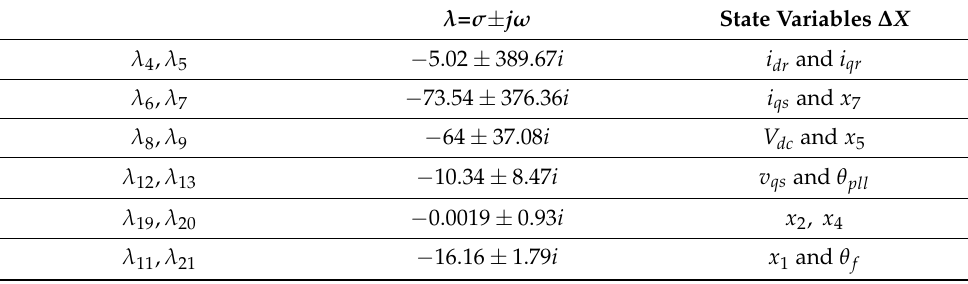
Table 1. Small-signal model eigenvalues and state